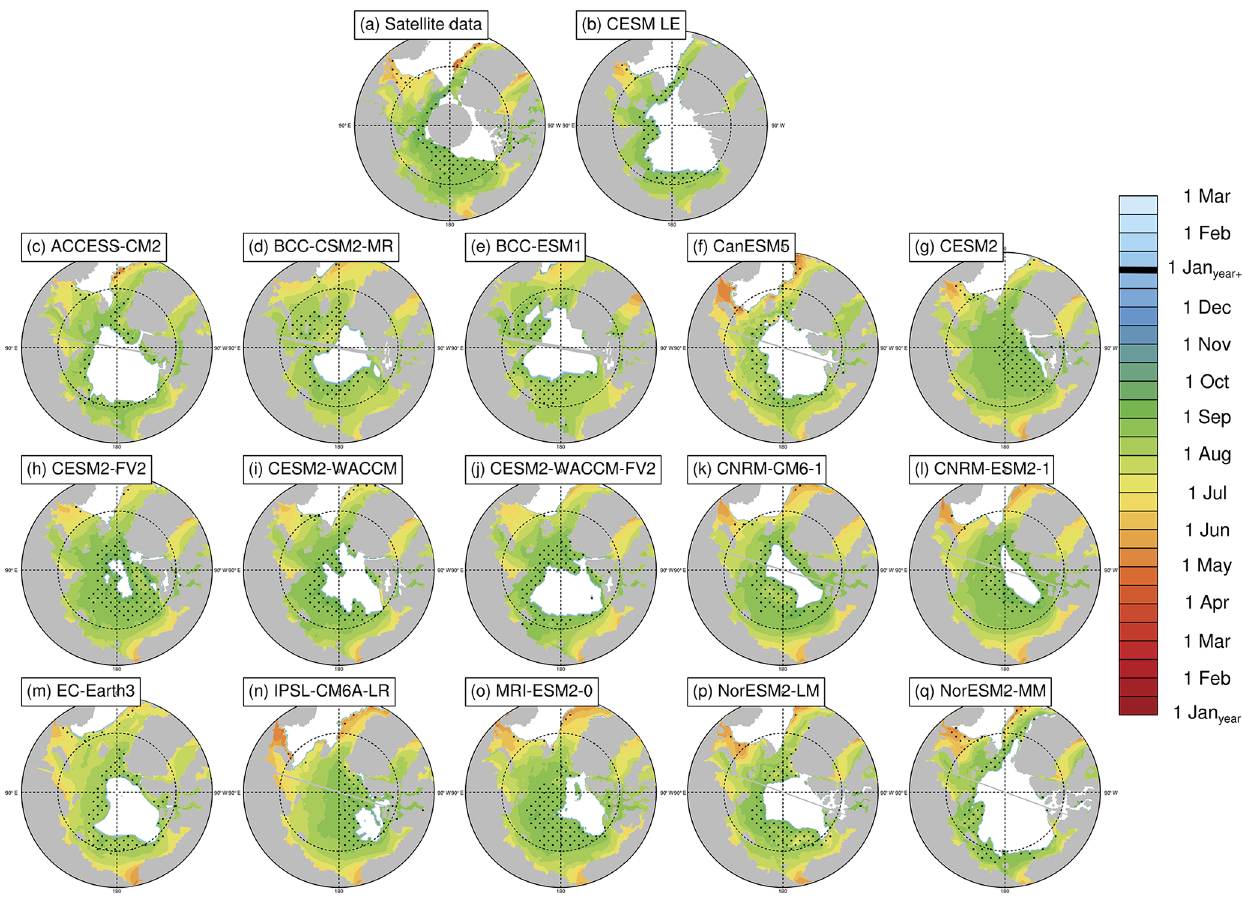
Figure 4. Breakup dates (15% ice concentration threshold) averaged over the period 1979–2014 at each grid cell using satellite data (a) , the first ensemble member of the CESM LE (b) , and the first ensemble member of each CMIP6 model (c–q) . Stippling indicates where breakup dates exist in less than 20% of years in the time range. Models on tripolar grids produce plot gaps filled by gray